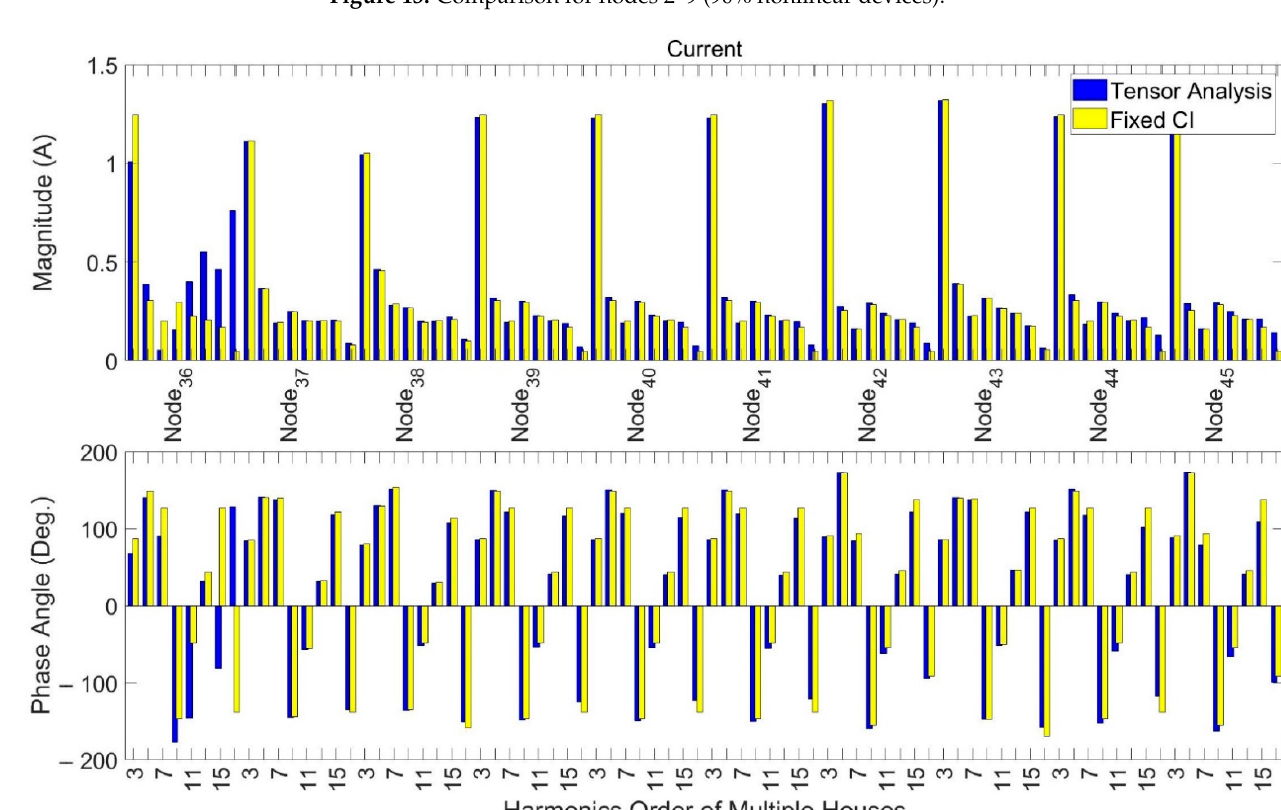
Figure 14. Comparison for nodes 36–45 (90% nonlinear devices).